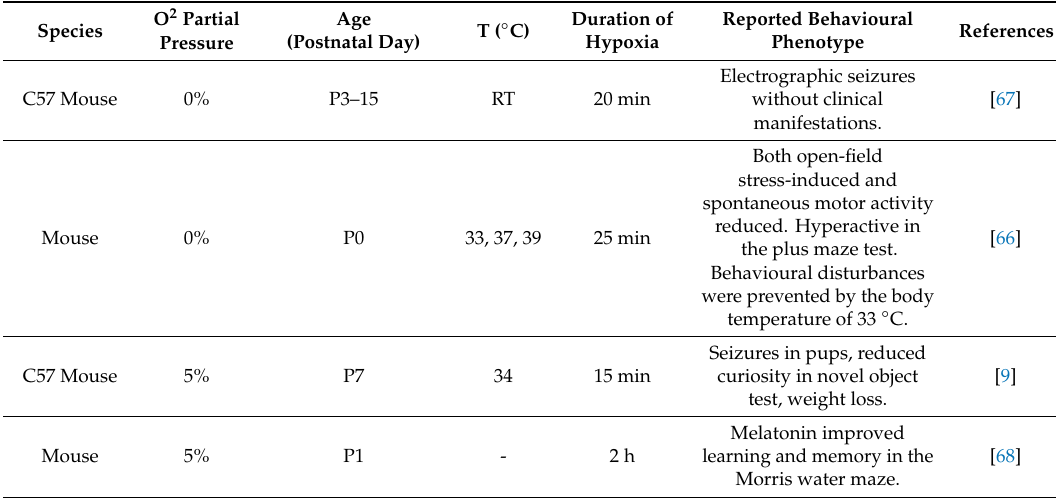
Experimental design for the hypoxia-only mouse models, along with the resultant behavioural